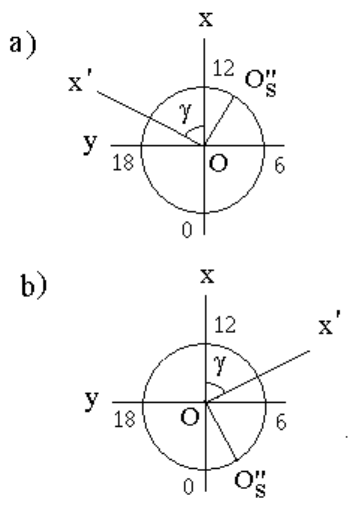
0 line 00 s marks a direction 0 s and the